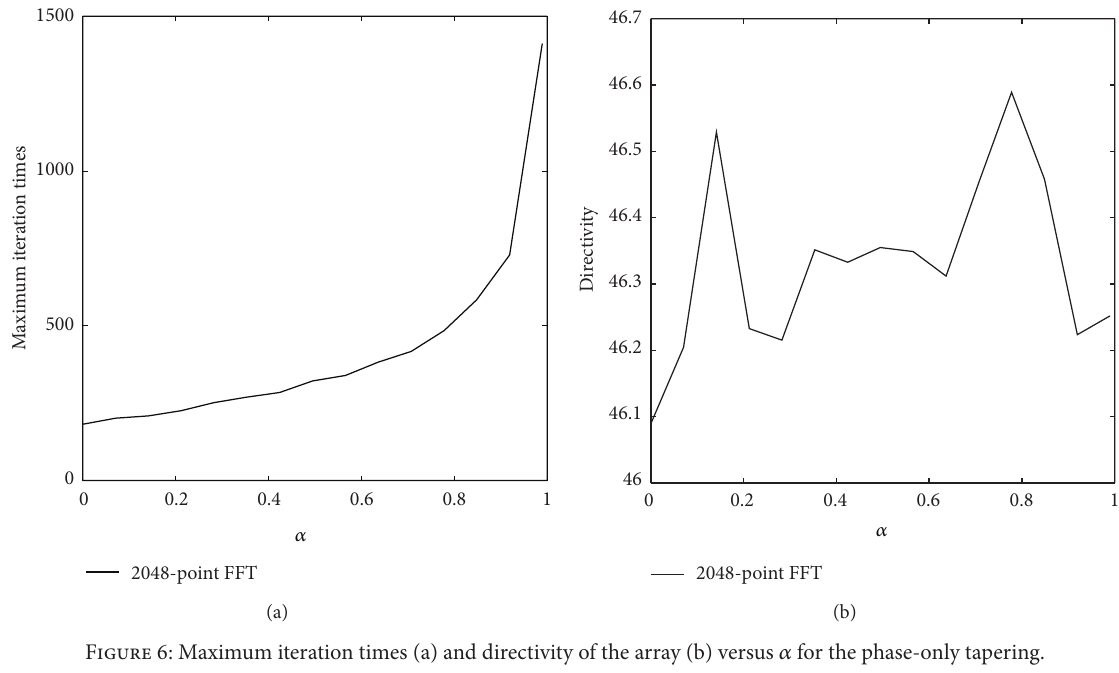
Figure 6: Maximum iteration times (a) and directivity of the array (b) versus 𝛼 for the phase-only tapering.